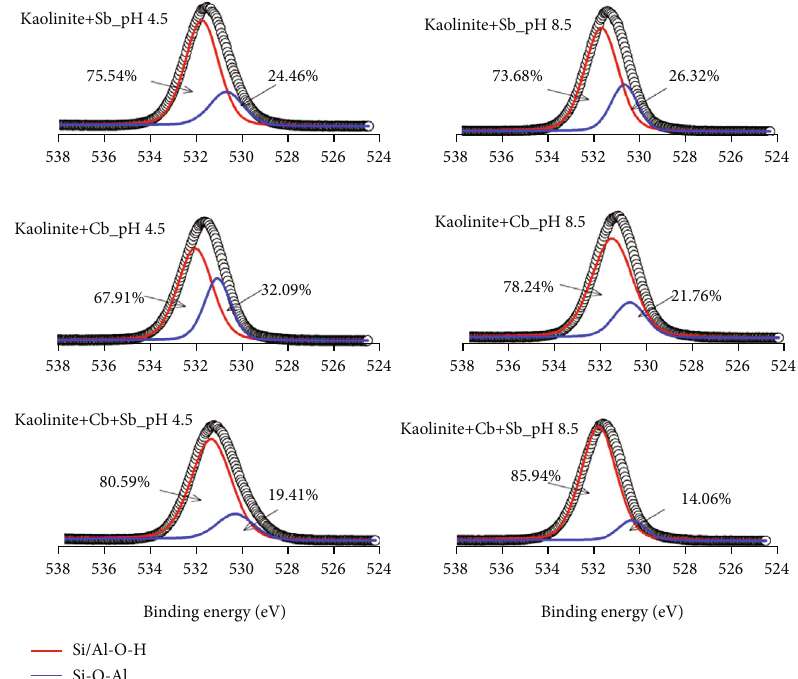
Figure 6: High-resolution O 1s XPS spectra of kaolinite after the sorption of Cd(II) and/or Sb(V).